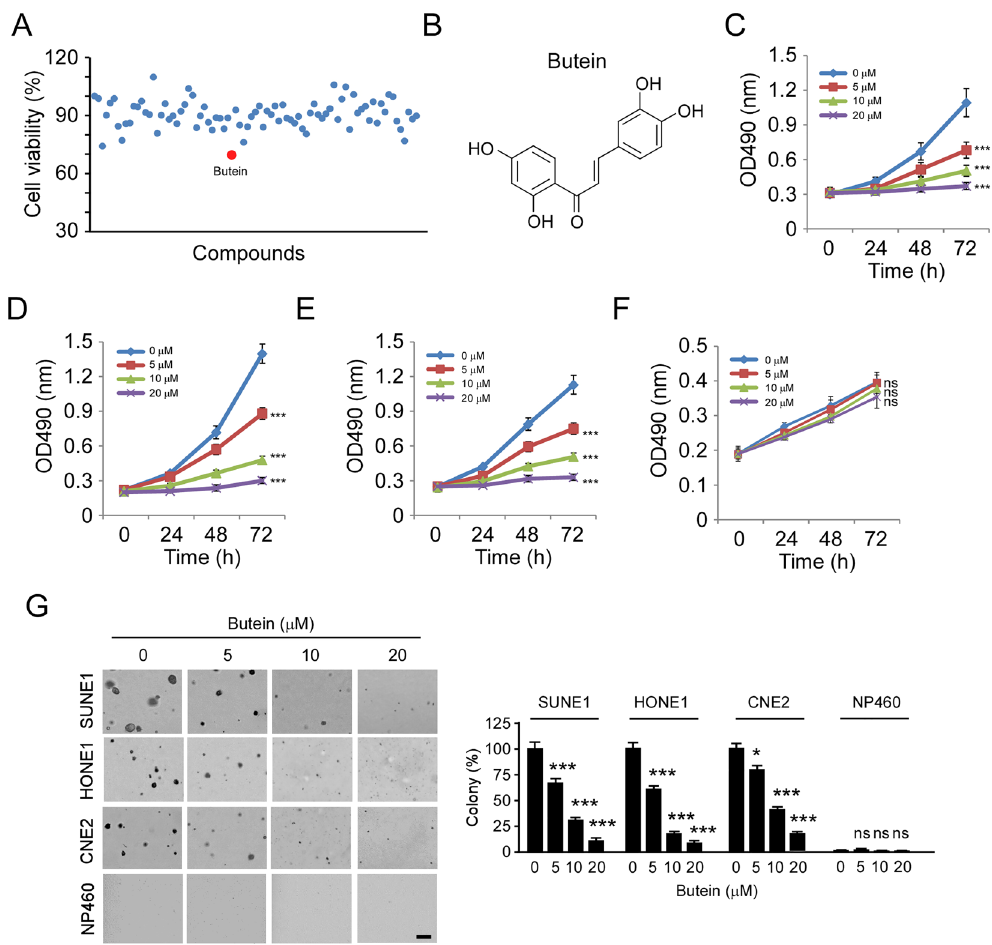
Figure 2. Butein inhibits NPC cells in vitro. ( A ) CNE2 cells were treated with the screened compounds for 48 h. Cell viability was examined by MTS assay. Red dot, Buttein. ( B ) the chemical structure of Butein. ( C – E ) MTS assay analysis of the cell viability of CNE2 ( C ), SUNE1 ( D ), and HONE1 ( E ) cells with Butein treatment. ( F ) MTS assay analysis of the cell viability of NP460. ( G ) Soft agar assay analysis of the colony formation of CNE2, SUNE1, HONE1, and NP460 cells. *p < 0.05, ***p < 0.001. ns, not statistically